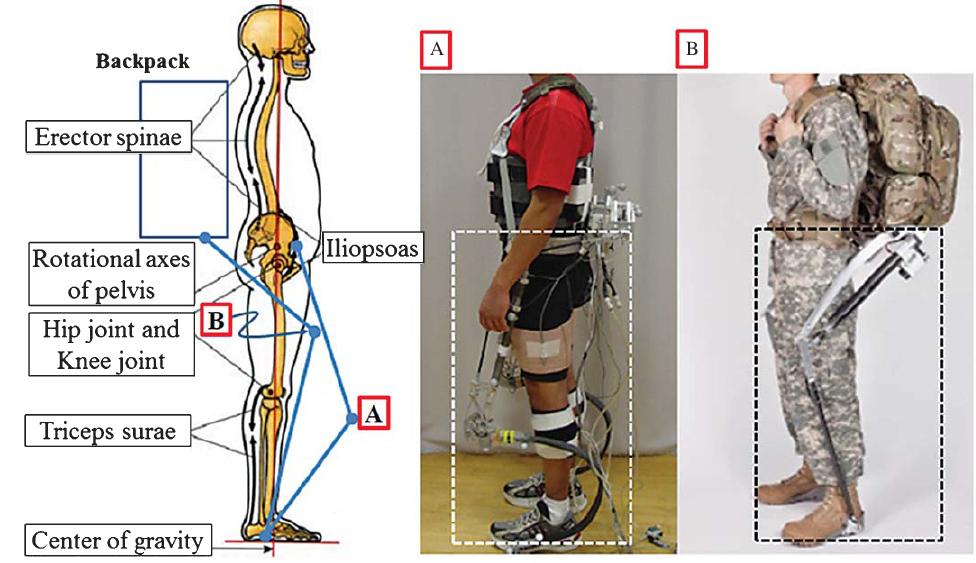
Fig. 3. Comparison of linkage structures of exoskeleton systems [22,